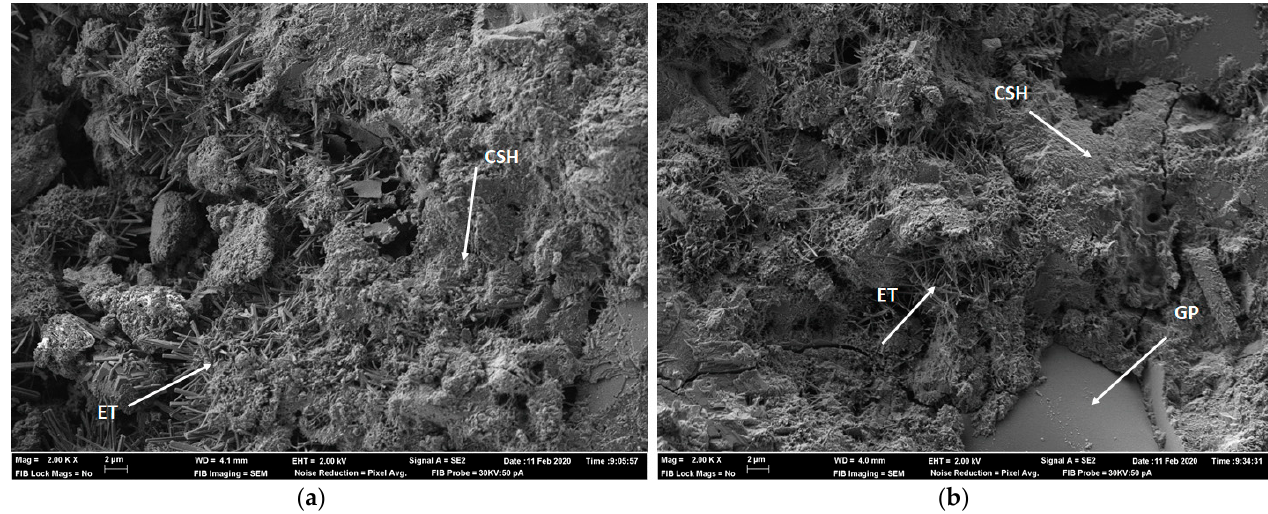
Figure 6. SEM analysis images for the control paste ( a ) and the GP paste ( b ) at 2000× magnification.